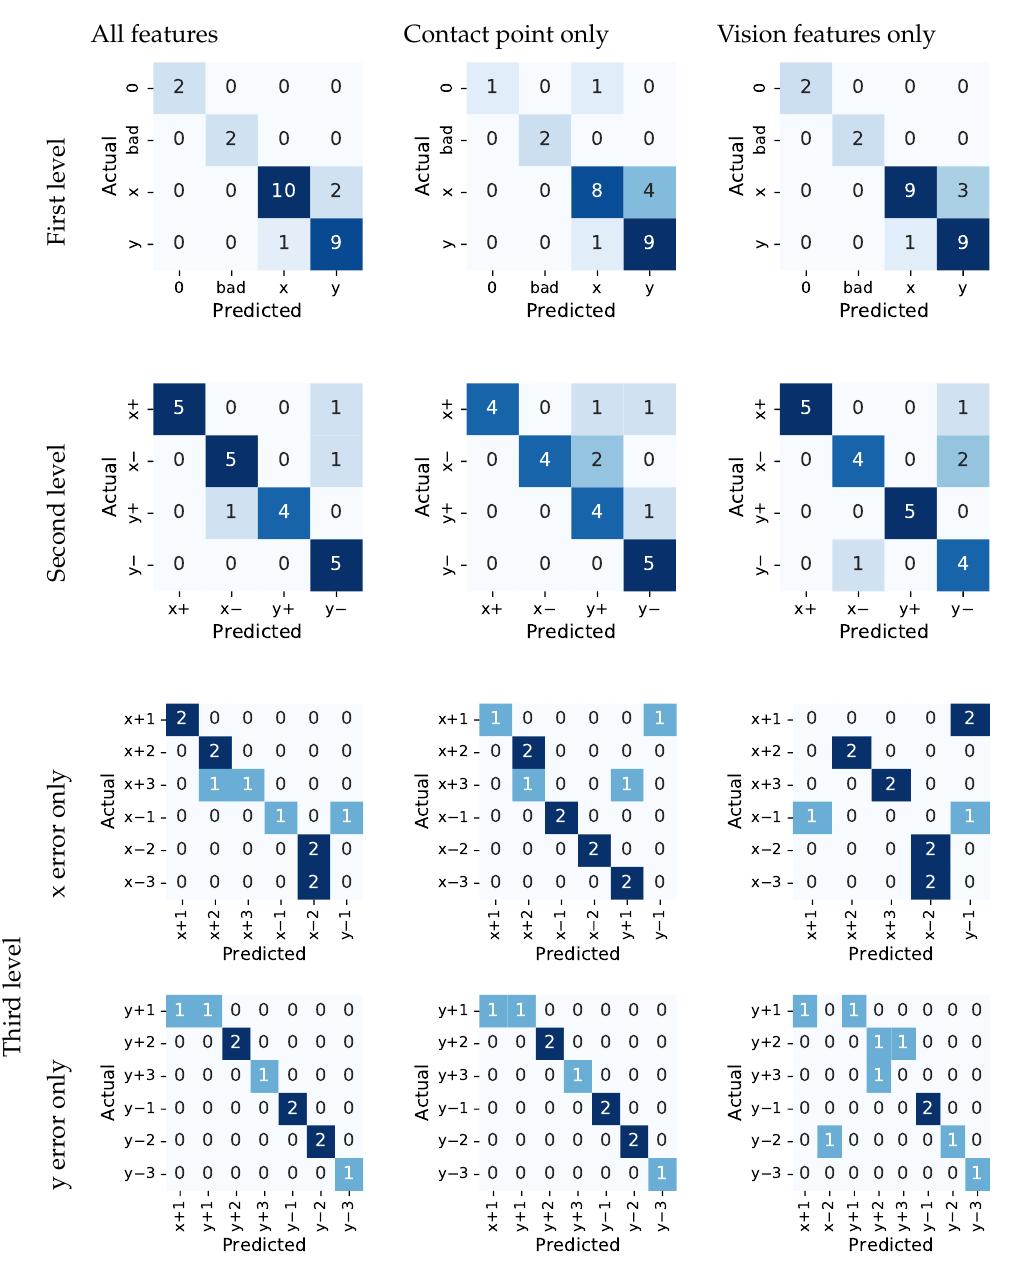
Figure 14. Confusion matrices for the copper ring insertion